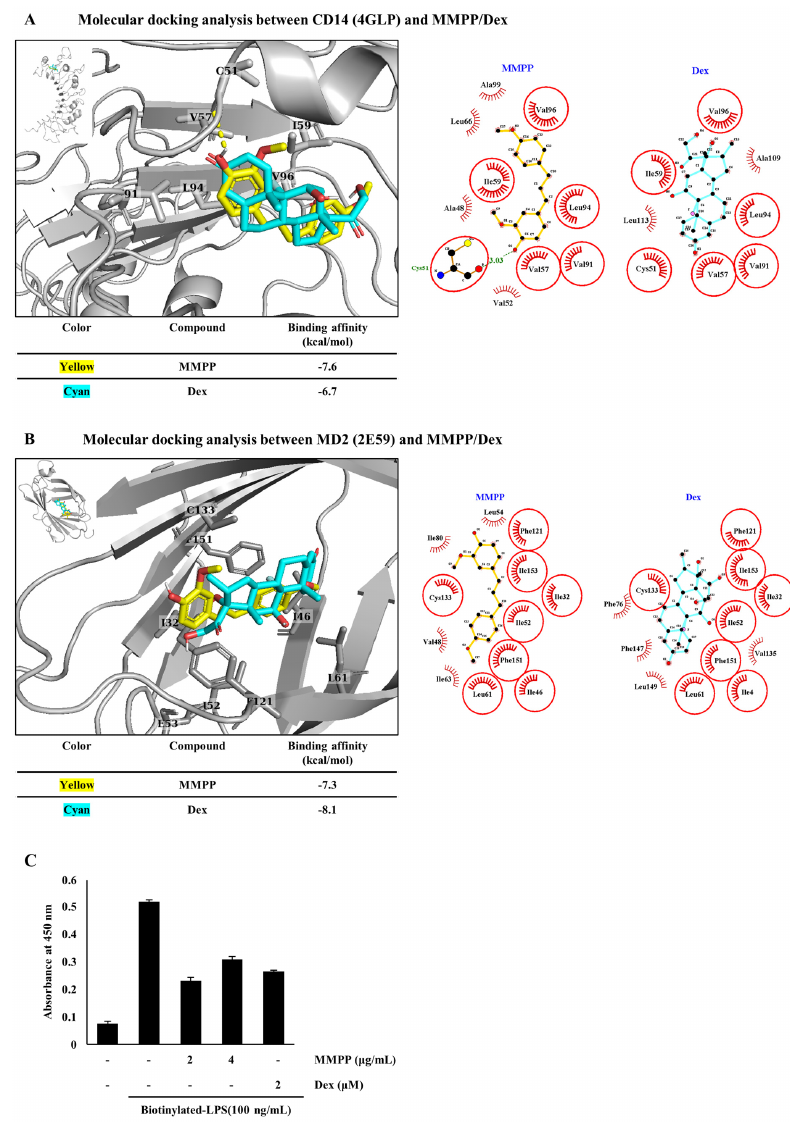
Figure 5. Inhibitory effects of MMPP on LPS binding to CD14 and MD2. ( A , B ) Molecular docking analysis showing the interactions between MMPP/Dex and CD14 or MD2. The PyMOL 3D diagram shows favorable docking results. The LigPlot+ 2D diagrams show the potential intermolecular